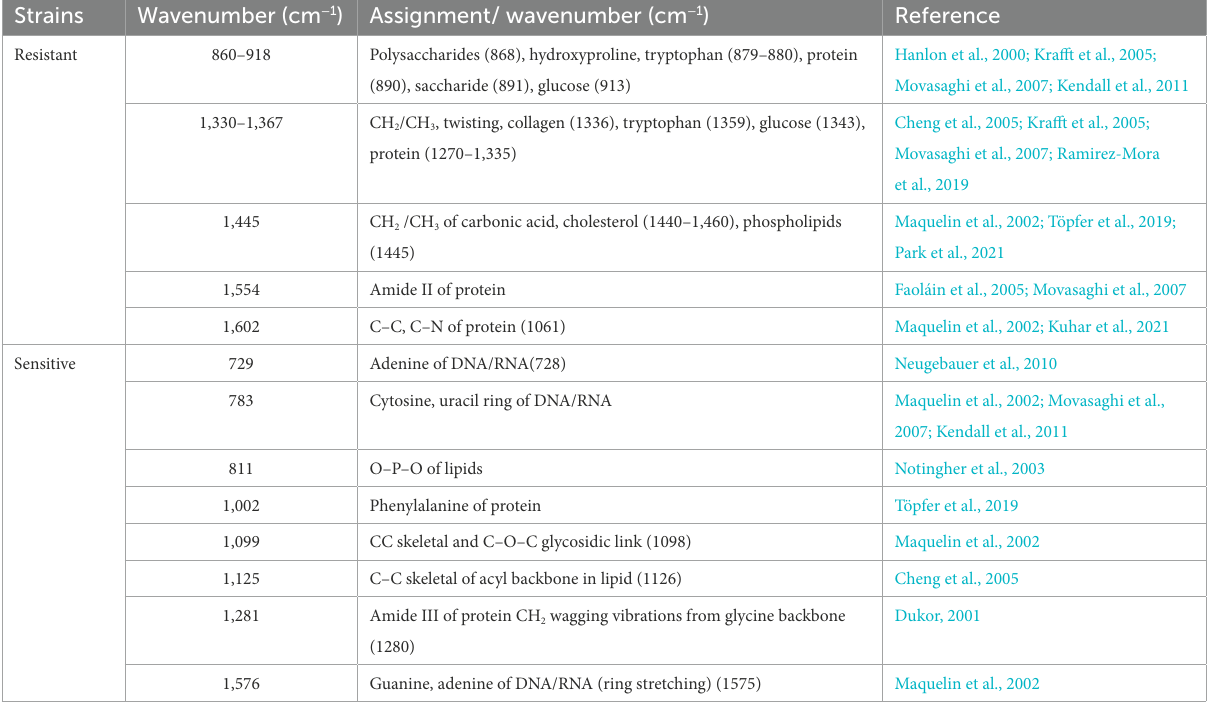
TABLE 1 Assignment of Raman bands in difference spectra between antibiotic-resistant and antibiotic-sensitive Acinetobacter baumannii . Strains